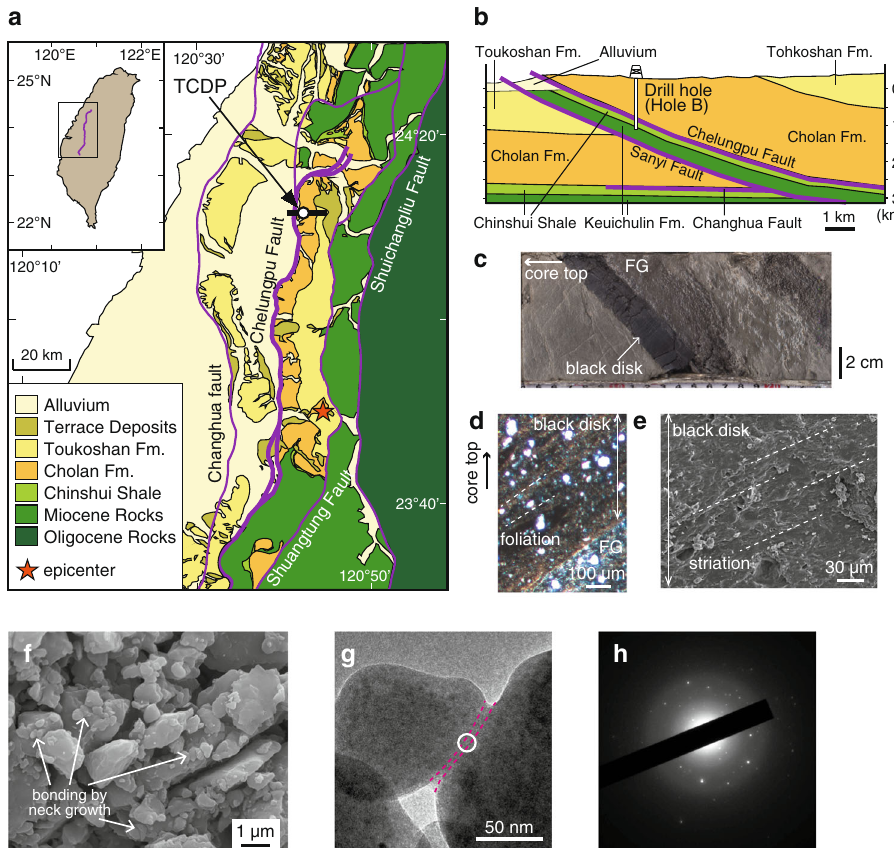
Fig. 1 The Chelungpu fault and the black disk-shaped fault rock. a Geological map of central Taiwan 5 . The 1999 Chi-Chi earthquake initiated on the southern Chelungpu fault, which ruptured both upward and northward. The Taiwan Chelungpu-fault Drilling Project (TCDP), started in 2002, penetrated the fault and recovered core samples from two holes (Hole A, total depth 2003 m; Hole B, total depth 1353m) 5 . b East – west cross section 5 . Fault rocks were recovered from three dominant fault zones, at depths of 1136, 1194, and 1243 m, in Hole B. c Core photo of a black disk-shaped fault rock, the surrounding fractured rock, and fault gouge from 1194-m depth in Hole B. Microstructures of the black disk observed under an optical microscope ( d ) and SEM ( e , f ). g Bright- fi eld TEM image of the neck between two ultra fi ne particles and h the electron diffraction pattern (within the white circle in g ), indicating the imperfect crystalline structure. Arrows in f and areas outlined by dotted red curves in g indicate neck growths. FG fault